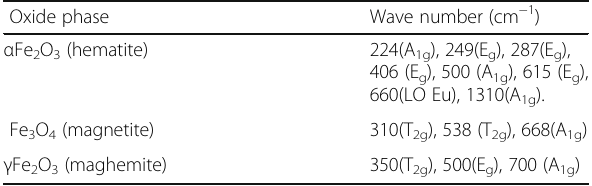
Table 1 Combined Raman data for iron oxides bands from [26 – 28] Oxide phase Wave number (cm − 1